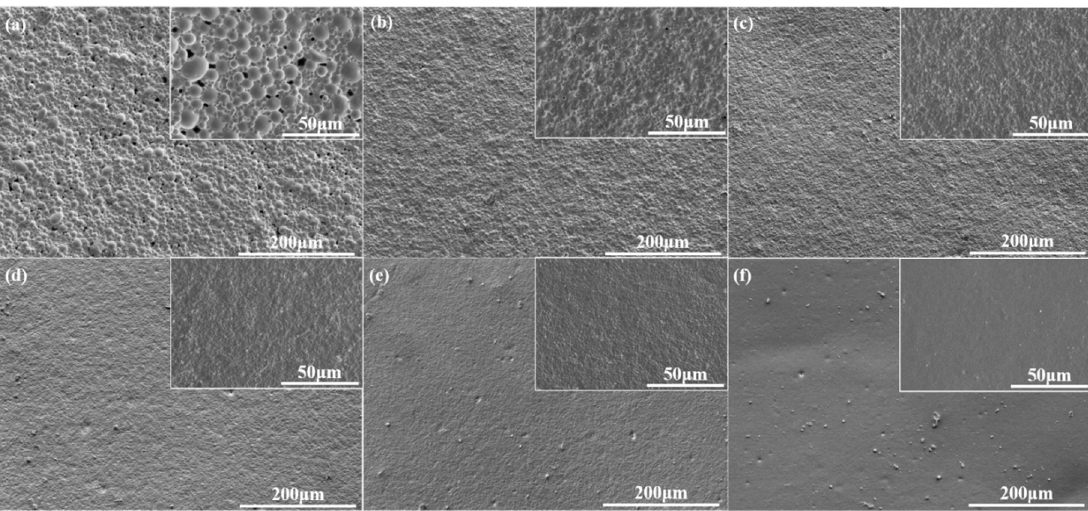
Figure 5. The transmittance of WPU-A films with different AAS contents.